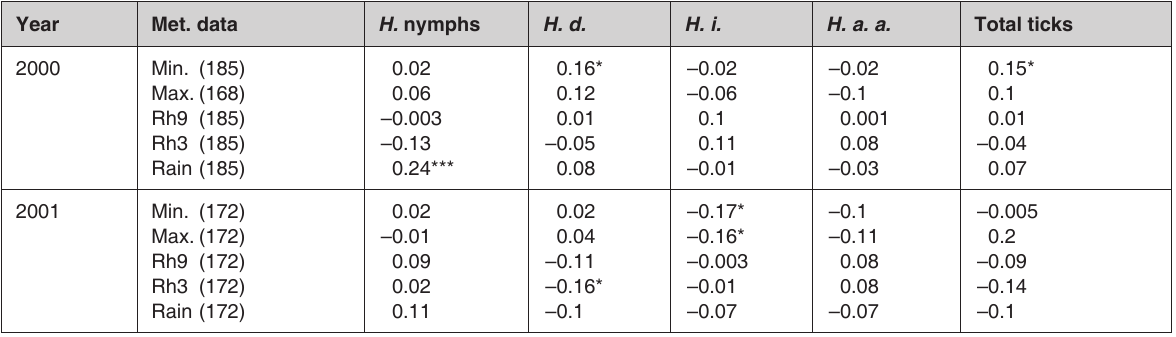
TABLE 8 Correlation analysis between ticks collected from camels with monthly meteorological values in 2000–2001 in River Nile